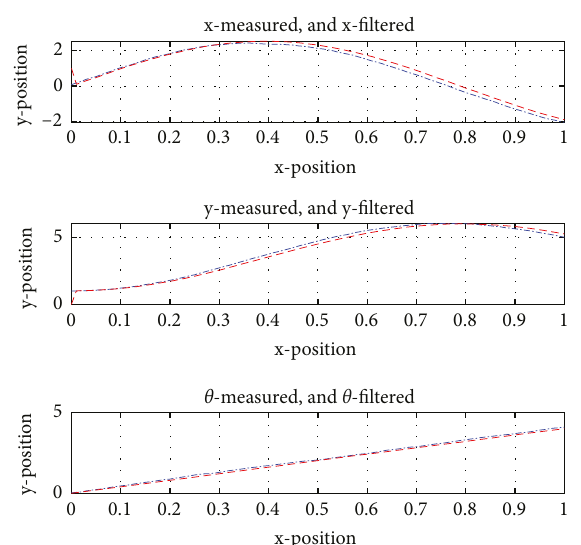
Figure 12: PF performance with one landmark and Gaussian noise.